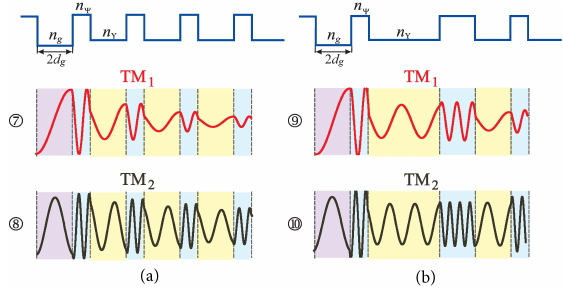
Figure 4: Magnetic-field patterns related to the H x component of the field for TM m modes. The refractive index profile of the corre- sponding waveguide is presented on the top of figure. The confine- ment factor is: (7) Γ = 0.3 ; (8) Γ = 0.14 ; (9) Γ = 0.23 ; (10) Γ < 0.1